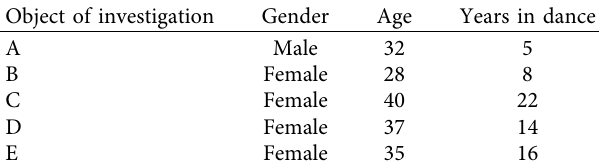
Table 1: Basic information of 5 dance artists.